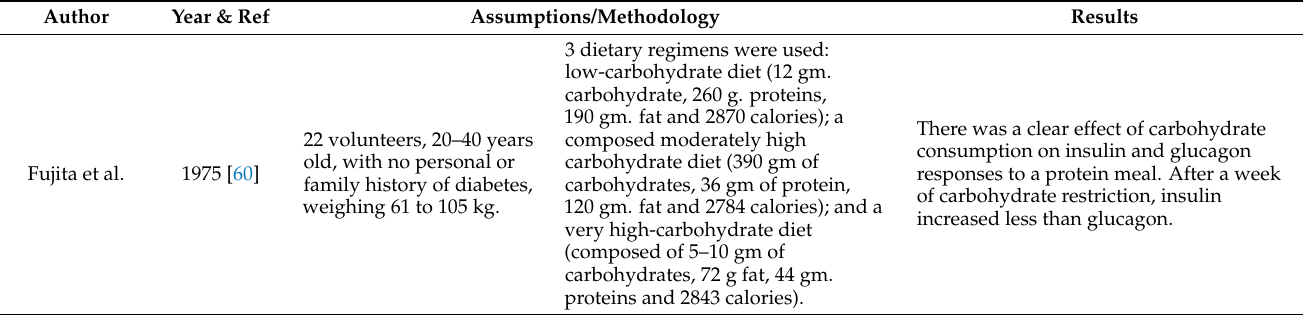
Table 4. Effects of Low glycemic index (GI)